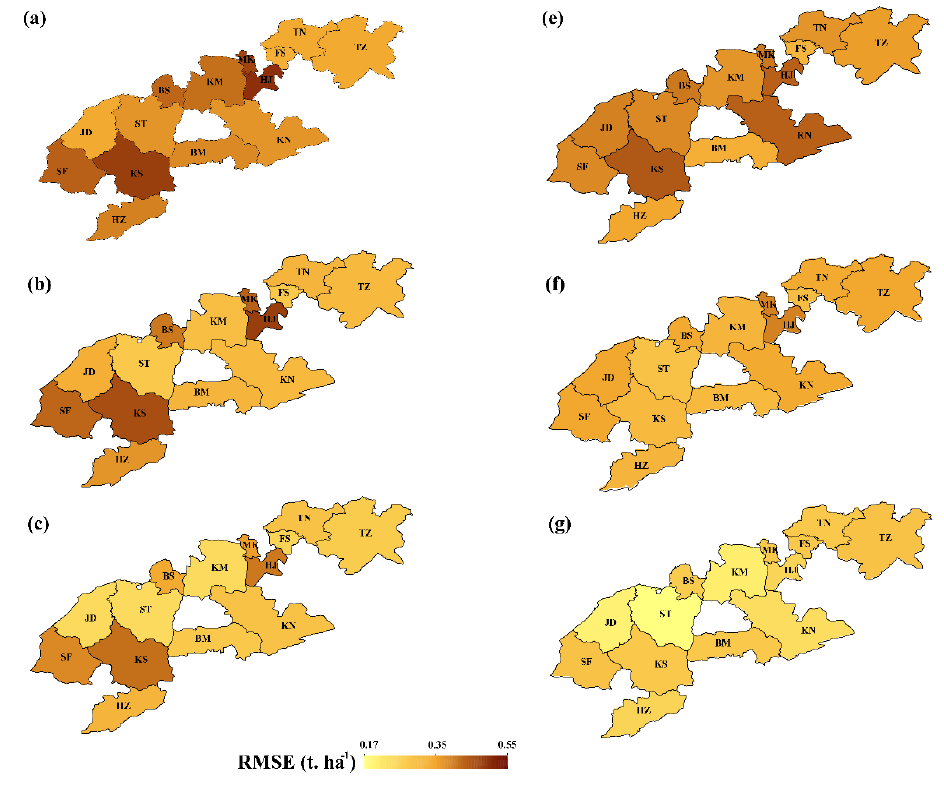
Figure 6. RMSE of global model at ( a ) January, ( b ) February, ( c ) March and regional models at ( d ) January, ( e ) February and ( f ) March.